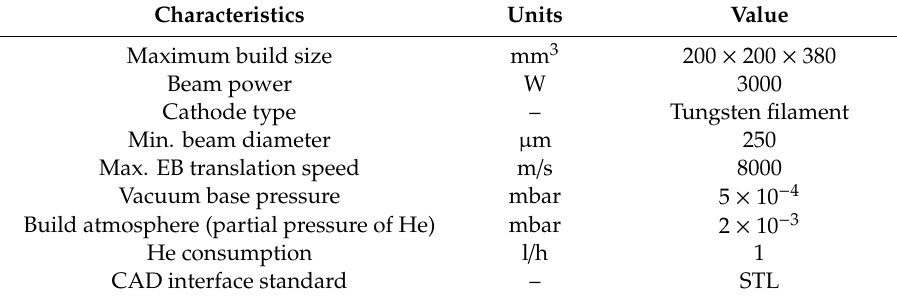
Table 1. Arcam A2X characteristics. Abbreviations: CAD: computer aided design; STL: standard triangulation